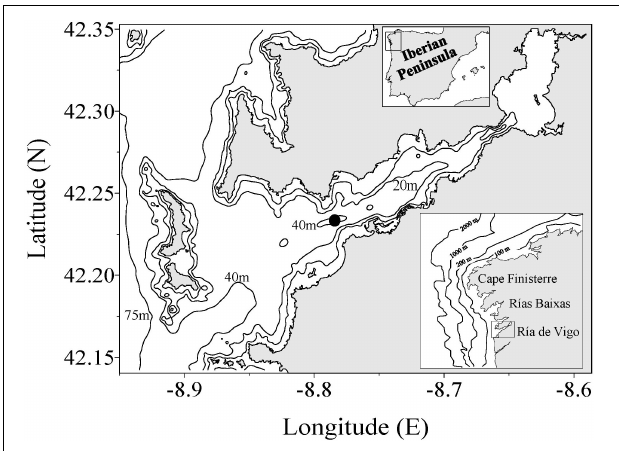
FIGURE 1 | Map of the Ría de Vigo showing the sampling site. The bottom inset is the location of the Ría de Vigo on the northwestern coast of the Iberian